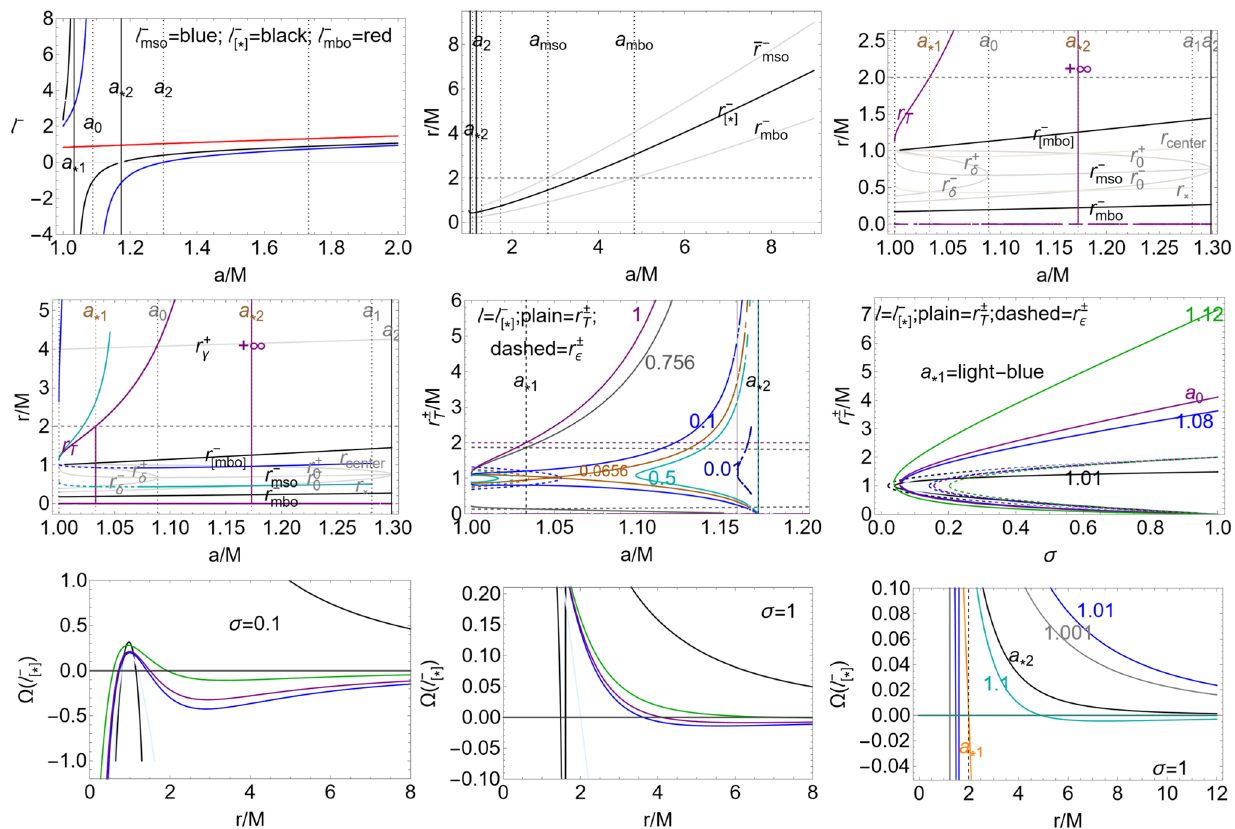
Fig. 22 Inversion points for flows with fluid specific angular momen- signed on the curves, as function of spin-mass ratio a / M (center panel) tum (cid:6) − . For (cid:6) − > 0 inversion points are only for space-like par- and as function of the plane, for different NS spin-mass ratio signed ticles with ( E < 0 , L < 0 ) in the conditions of Sec. (C). The on the curves (right panel) for fluid specific angular momentum (cid:6) − [∗] . most general solutions r ± (cid:2) are shown not considering constraints of Notethelocationoftheinversionradiuswithrespecttotheergosurfaces r ± (cid:11) (dashed curves). Bottom line panel: analysis of the flows inversion Sect. 3.2. Spins { a 0 , a 1 , a 2 } are defined in Table 2. Spins { a ∗ 1 , a ∗ 2 } are defined in Eq. (15), spins { a mso , a mbo } are defined in Eq. (14). There points in terms of the relativistic angular velocities (cid:3) evaluated for )/ 2. Upper left panel: particles with fluid specific angular momentum (cid:6) = (cid:6) − [∗] for different is (cid:6) − [∗] ≡ (cid:6) − ( r − [∗] ), r − [∗] ≡ r − mso − ( r − mso − r − mbo plane sigma σ and spins as signed on the planes (left and right panels) (on the marginally sta- fluid angular momentum (cid:6) − [∗] and (cid:6) − mso , (cid:6) − mbo accordingtonotationofthecenter-lineright-panel.Thereis (cid:3)( r ± (cid:2) ) = 0. ble and marginally bounded orbit respectively) as functions of the NS Bottom right panel shows (cid:3)((cid:6) − [∗] ) on the equatorial plane (σ = 1 ) for spin-mass ratio. Upper Center panel: geodesic structure of the Kerr NS different spins a / M signed on the curves. Note the presence of two and radius r − [∗] as function of a / M . Upper right panel and center-line inversion points for each curve at σ < 1. The analysis for the counter- left panel show the inversion radius r (cid:2) (on the equatorial plane) for the rotating tori with fluid specific angular momentum (cid:6) = (cid:6) + < 0 is in torus model with center radius r center and cusp r × , where (cid:6) = (cid:6) − [∗] . Fig. Center-line right and center panels:: inversion point radius r ± (cid:2) for dif- ferent planes σ ≡ sin 2 θ ∈ [ 0 , 1 ] ( σ = 1 is the equatorial plane),